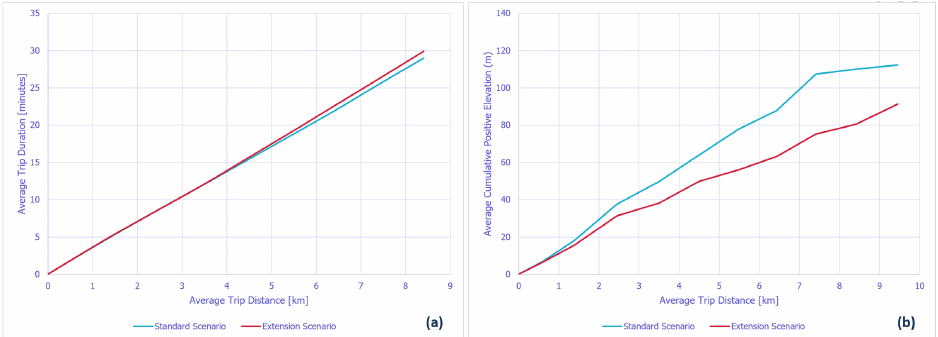
Figure 9. Average travel duration ( a ) and travel positive elevation ( b ) by travel